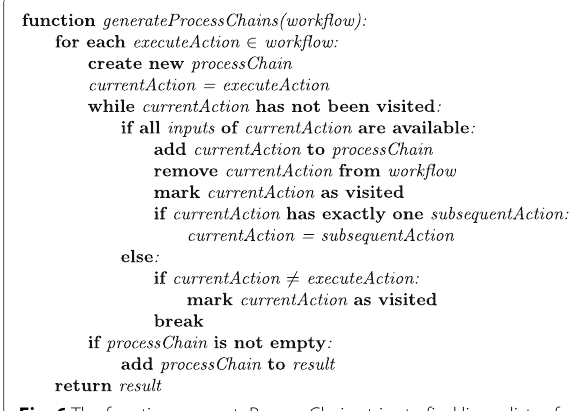
Example 2: ordinary for-each